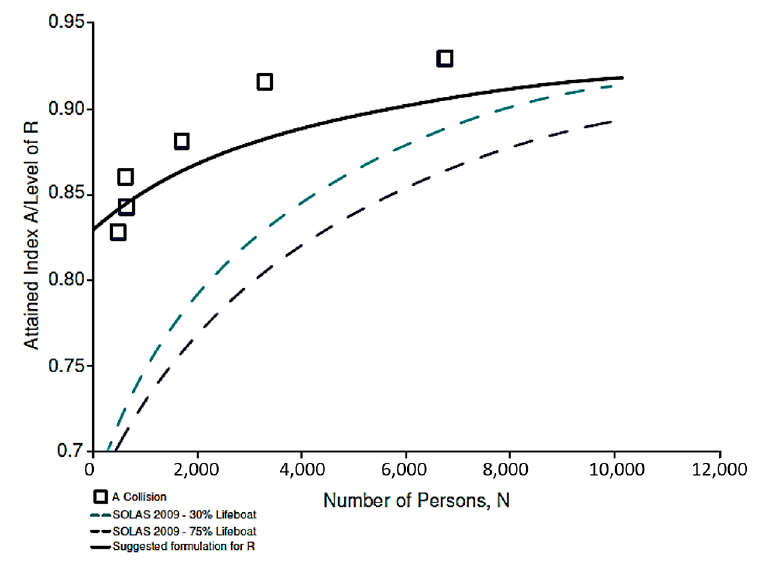
Figure 5. EMSA III research outcome on passenger ships’ level of R index.